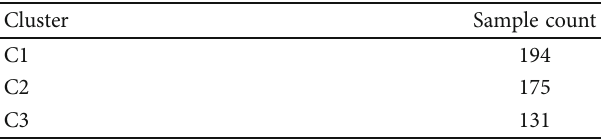
Figure 1: The fl ow chart of this study. Table 1: Number of samples of three